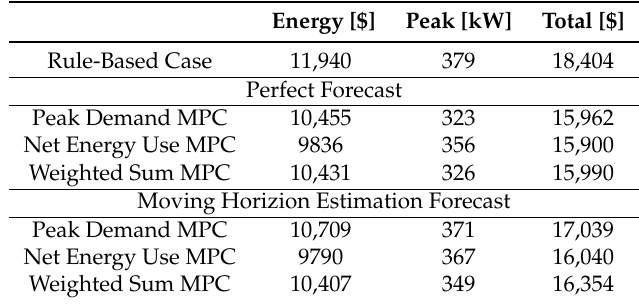
Table 2. Comparisons between the rules-based control and MPC schemes in terms of energy cost and peak load for a month-long simulation, under low and high solar availabilities, and for perfect and imperfect forecasting conditions.